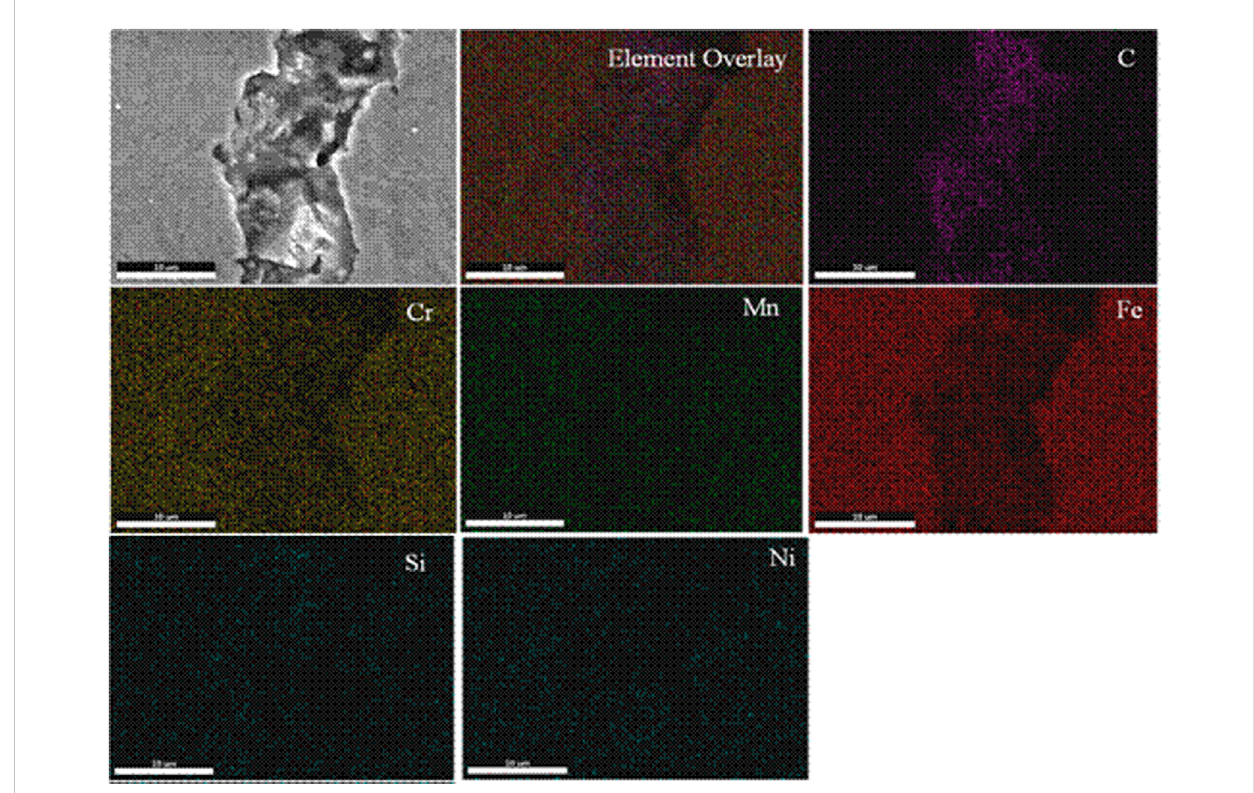
FIGURE 7 Element distribution near the fatigue crack.